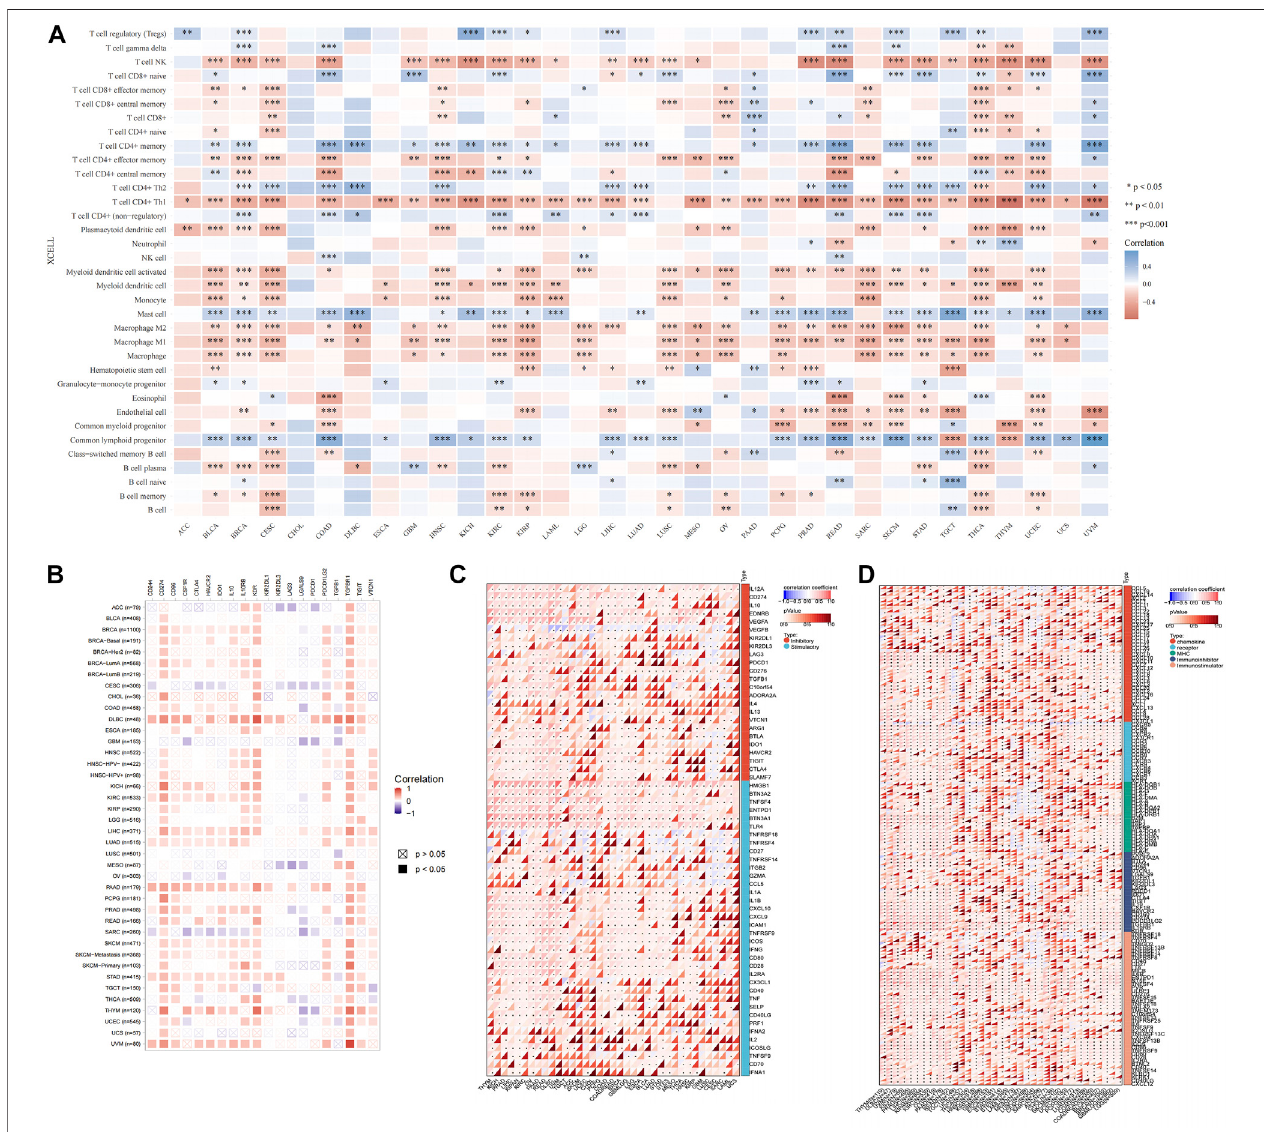
FIGURE 7 | Correlation of USP45 with tumor immunity in different types of tumors. Based on the TCGA database, the xCELL algorithm was used to analyze the correlation of USP45 with tumor-in fi ltrating immune cells (A) , immune checkpoint molecules (B,C) and immune regulators (D) . * p < 0.05, ** p < 0.01, *** p < 0.001.